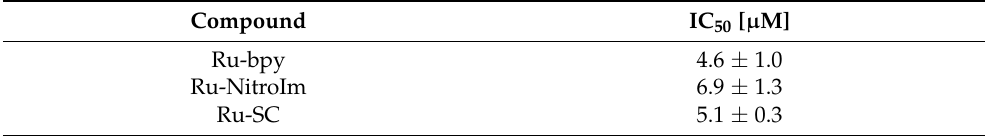
Table 1. Cytotoxicity (IC 50 ) of the studied Ru (II) complexes against HMEC-1 cells. Experiments were performed in triplicate and repeated three times. Results are presented as mean values and standard error of the